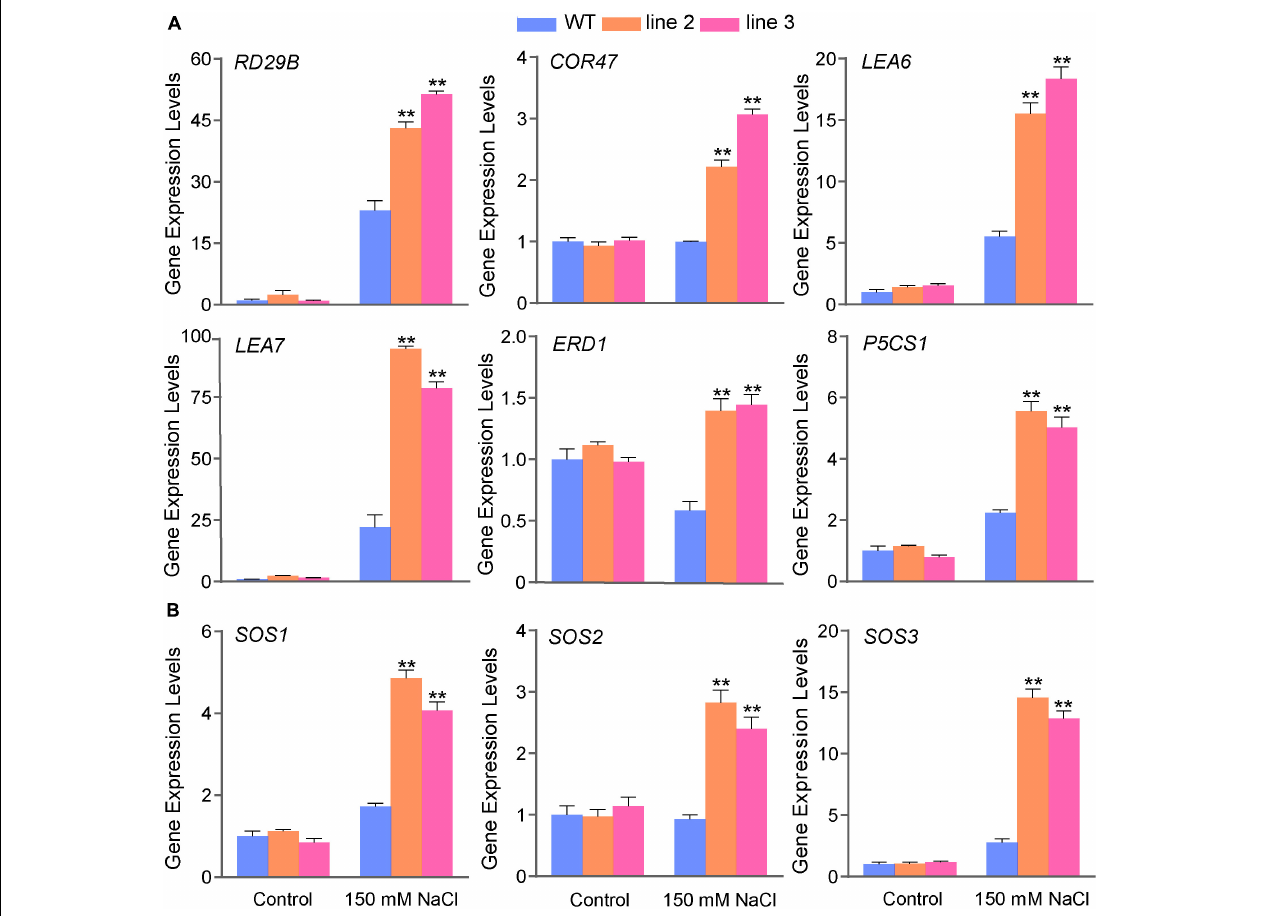
FIGURE 6 | Gene expression level analysis of classic stress-related genes and SOS genes in ScDREB5 transgenic Arabidopsis response to salt stresses. (A) Abiotic stress-responsive genes were analyzed by RT-qPCR in WT and ScDREB5 transgenic plants under normal and salt stress conditions. (B) SOS genes ( SOS1 , SOS2 , and SOS3 ) were analyzed by RT-qPCR in WT and ScDREB5 transgenic plants under normal and salt stress conditions. Total RNA was extracted from whole plants. The 2 − (cid:49)(cid:49) Ct method was used for RT-qPCR normalization. The α -TUBULIN ( AT1G50010 ) gene of Arabidopsis were used as the reference gene. Values are means ± SE of three replicates. Significant difference compared with WT plants with the same treatment. LSD multiple comparison test was used: * p < 0.05, ** p <